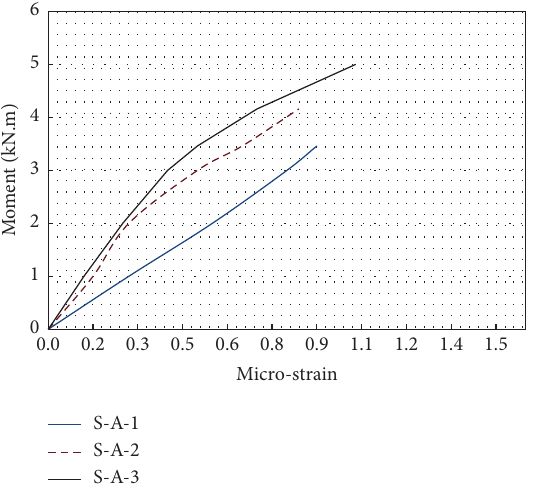
Figure 8: Relation between moment and strain at midspan of the bottom flange (group A beams).